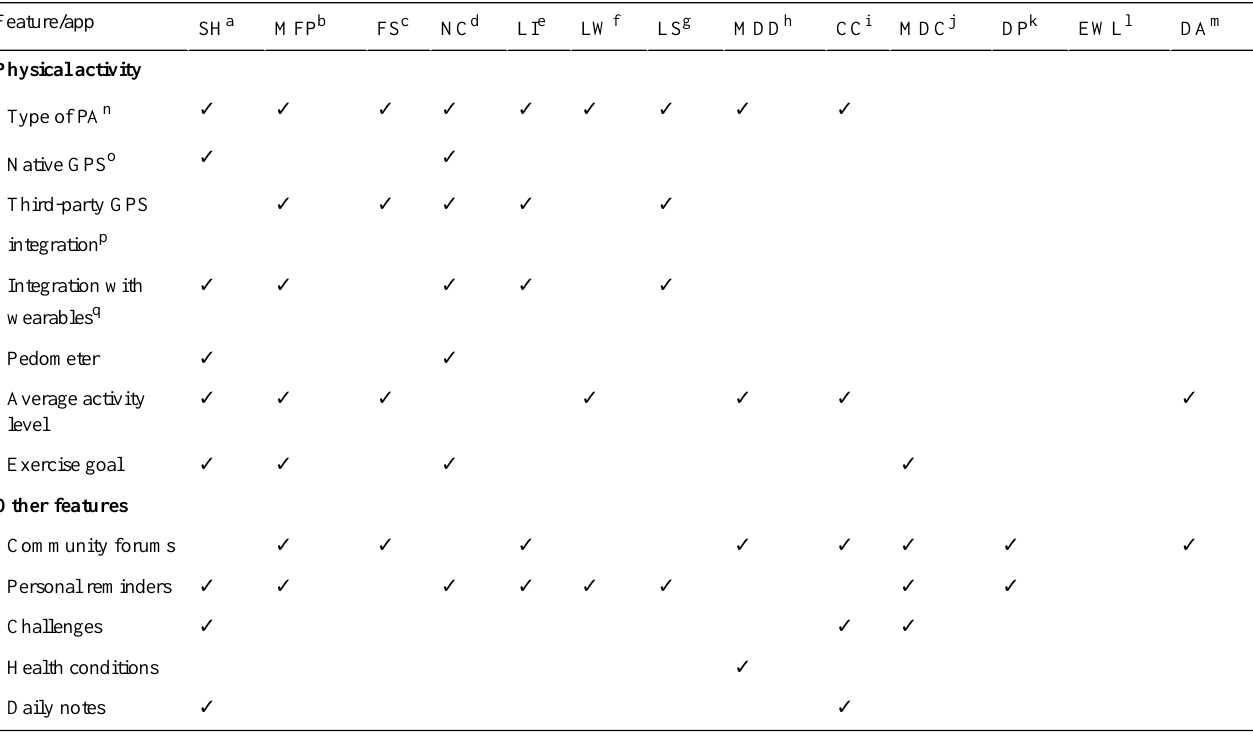
Table 4. Nutrition-related app features for physical activity and other input